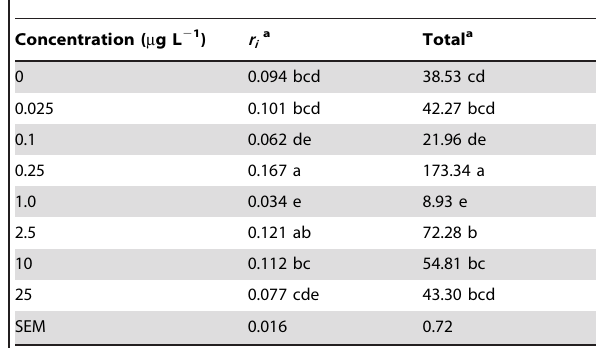
Table 5. Least-squares means of the instantaneous rate of increase ( r i ) and total number of aphids per plant after 21